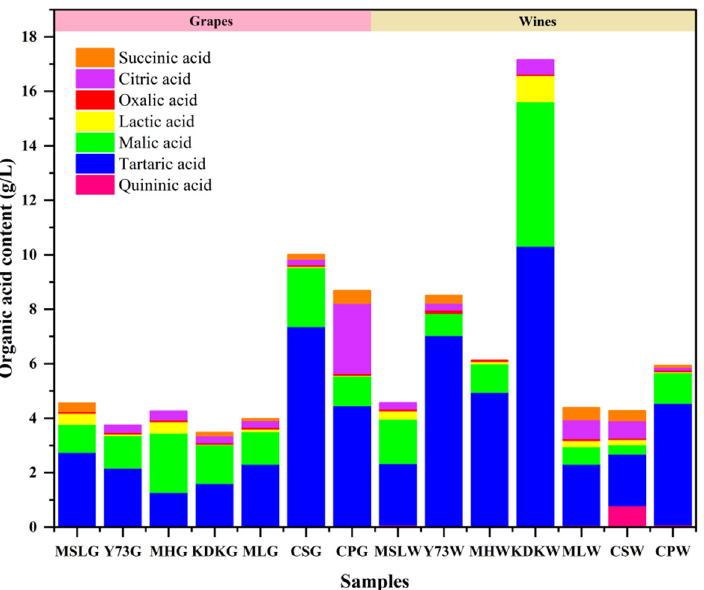
Figure 1. Difference in seven organic acid contents (g/L) in seven grape cultivars and corresponding wines. Samples’ full names are as follows: MSL (Marselan), Y73 (Yan 73), MH (Muscat Hamburg), KDK (Kadarka), ML (Merlot), CS (Cabernet Sauvignon) and CP (Crimpose). Furthermore, G repre- sents “grape” and W represents “wine”.